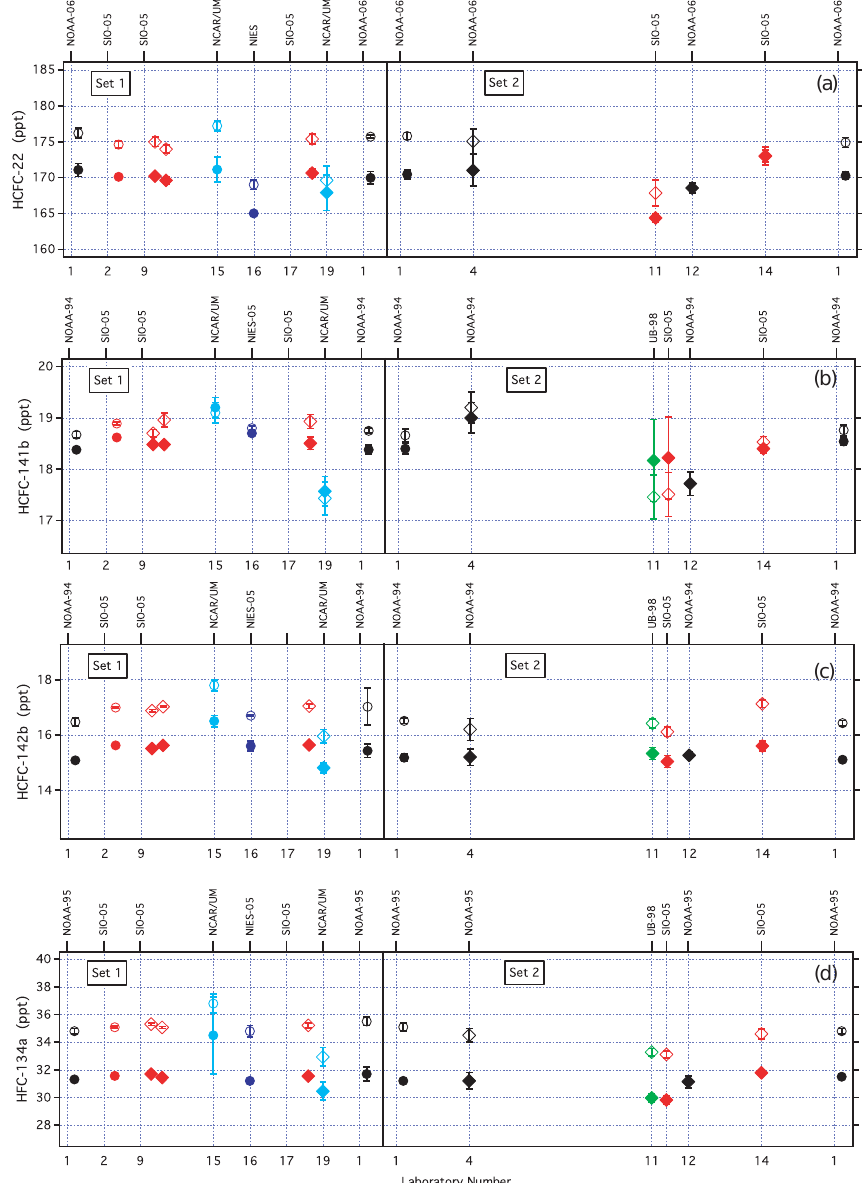
Fig. 3. Same as Fig. 1 for trace gases (a) HCFC-22, (b) HCFC-141b, (c) HCFC-142b, (d) HFC-134a.